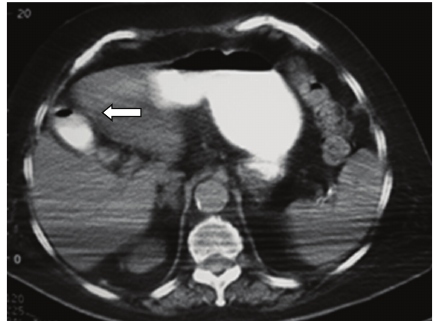
Figure 3: Contrast and air inside the gallbladder (arrow).